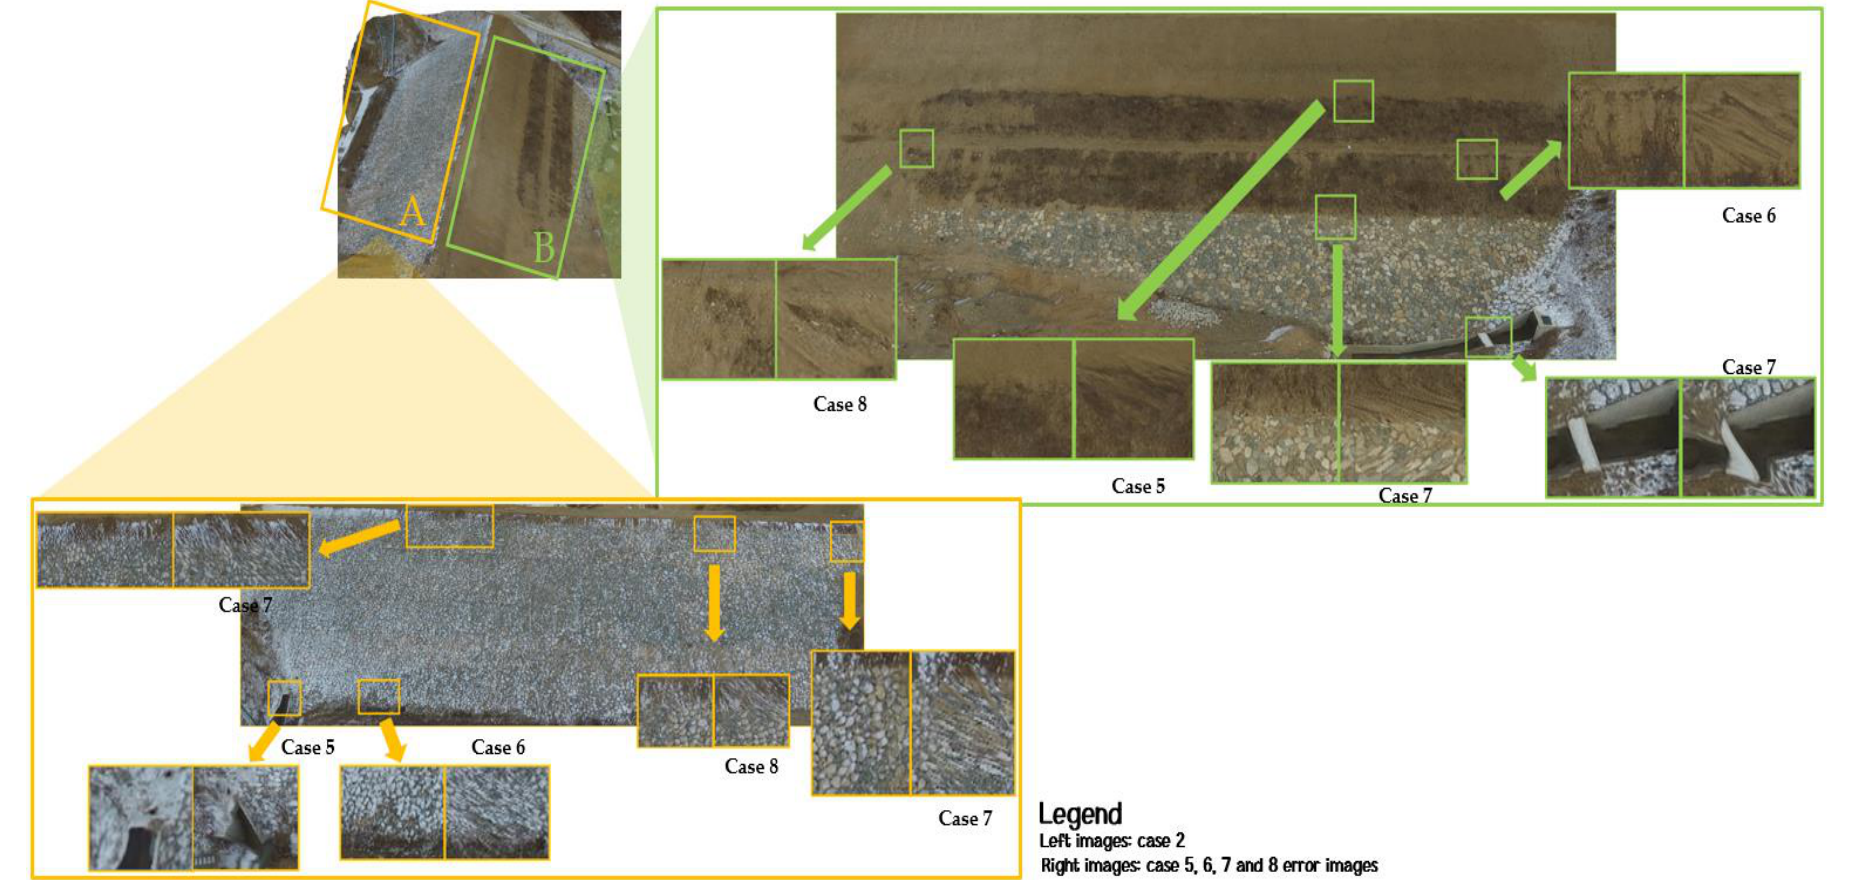
Figure 8. The 3D model visual inspection evaluation of the earthworks study site ( left images: case 2, right images: cases 5, 6, 7, and 8).